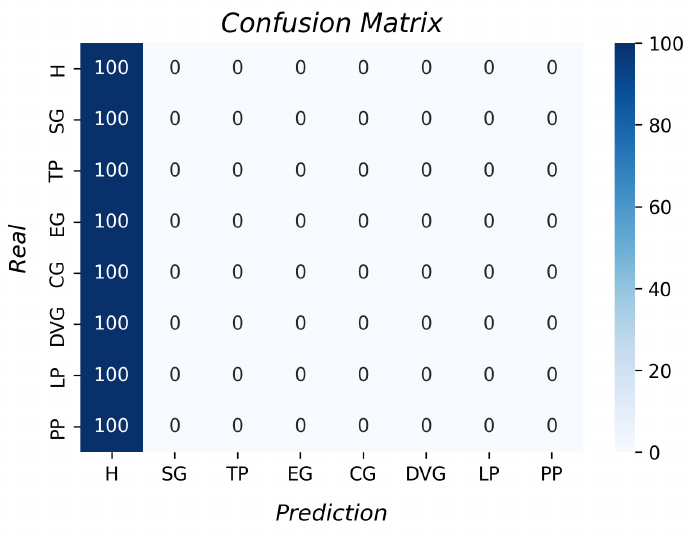
Figure 17. Accuracy per type of grasp for the hierarchical clustering